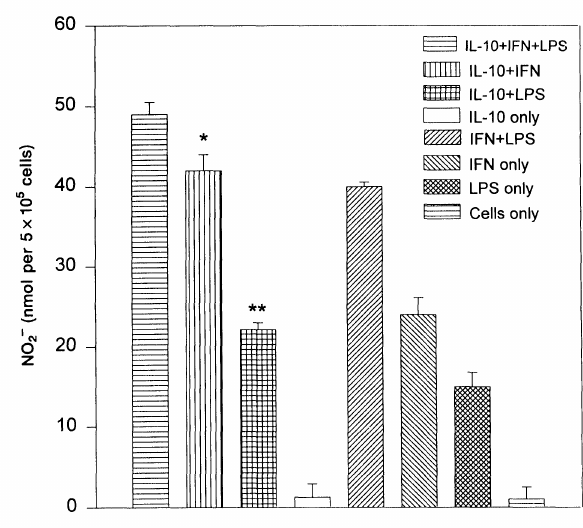
FIG. 2. Effect of pre-treatment of macrophages (RAW 264.7) with IL-10 (100 U/ml) on IFN-y (100 U/ml) or LPS-(100 ng/ml) induced nitric oxide production. Data are mean separate experiments performed in